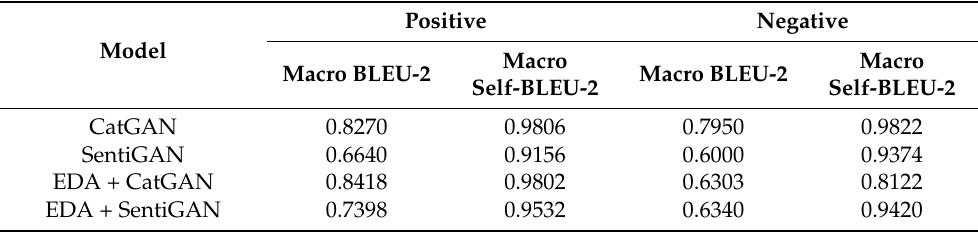
Table 3. Result of generated sample similarity of the BLEU-2 and self-BLEU-2 in five-fold cross validations.